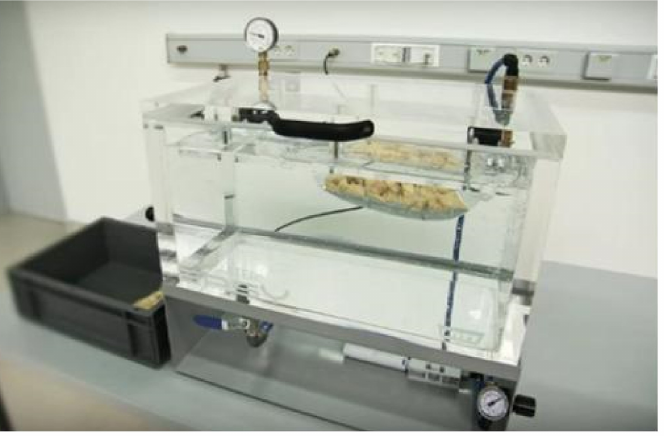
Figure 10. Leak detection by Leak Master Easy ®®® device, reprinted with permission from WITT